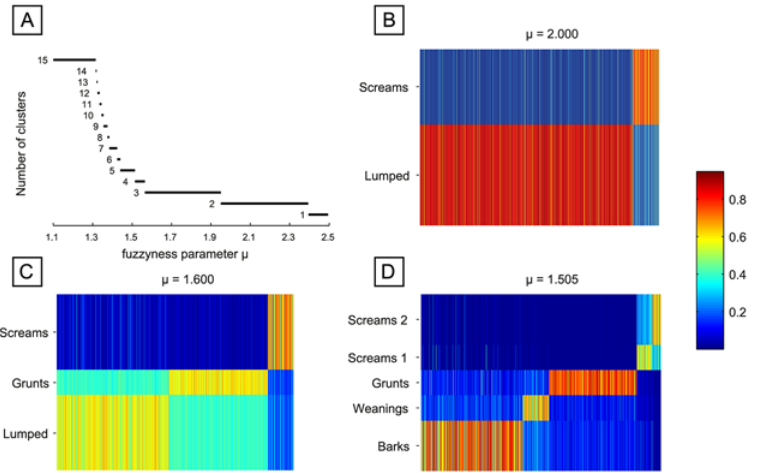
Fig 5. Fuzzy partitions with decreasing fuzziness ( μ values) are visualized as membership matrices. (A) Number of clusters in dependence on the fuzziness parameter μ . Partitions with more than five clusters exist only over very narrow ranges of μ values (red). (C-D) membership matrices for the identified clusters: Rows correspond to different fuzzy clusters and columns to individual calls. Membership values of single calls to each class are color coded (B). The scream-cluster is the first to emerge (cluster 1, C), followed by grunts (cluster 2, D). The scream-cluster splits into two clusters and the weaning-cluster emerges (cluster 1 – 2; cluster 4,